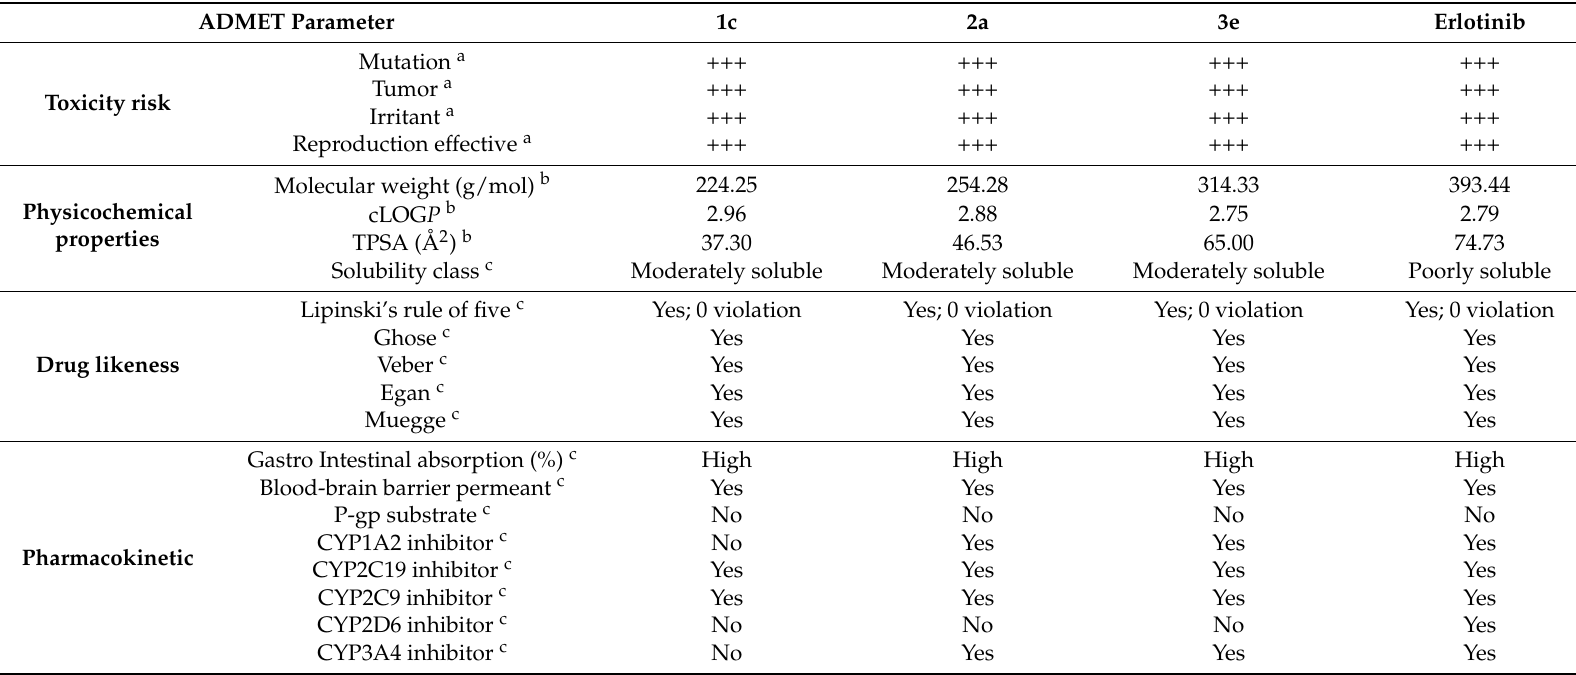
Table 2. Absorption, distribution, metabolism, excretion, and toxicity (ADMET), drug-likeness, and pharmacokinetics of three potent